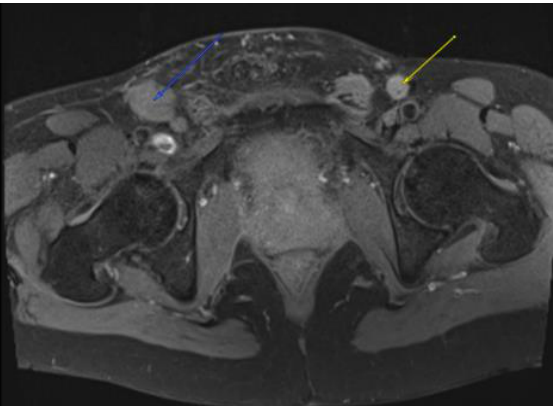
Figure 4. MRI in the axial view T1 TSE FS pre-showing 11 mm R common iliac lymph node.